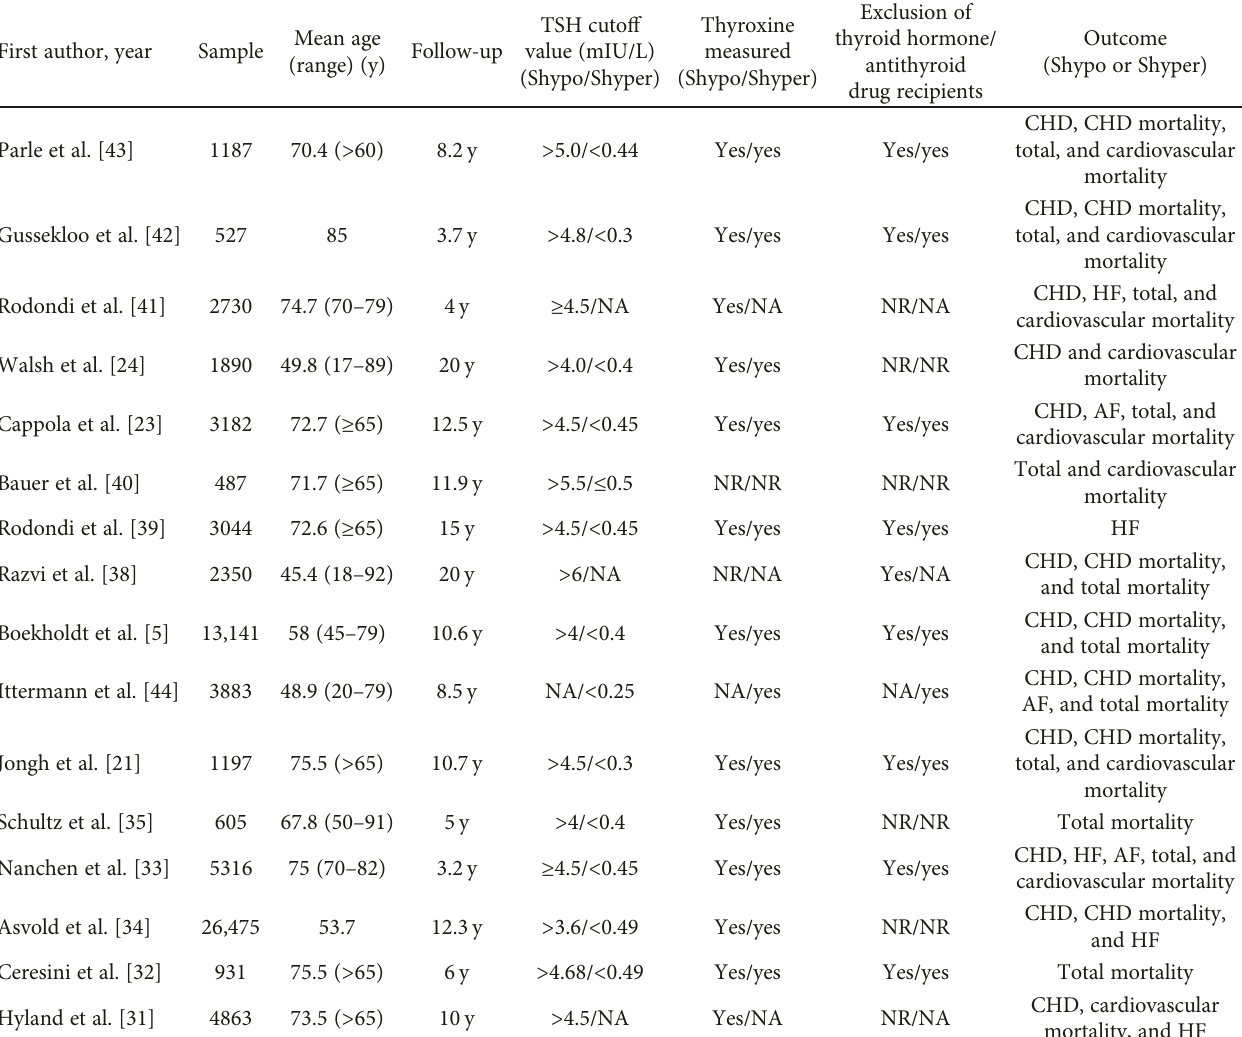
Table 1: Baseline characteristics of subclinical thyroid dysfunction in included